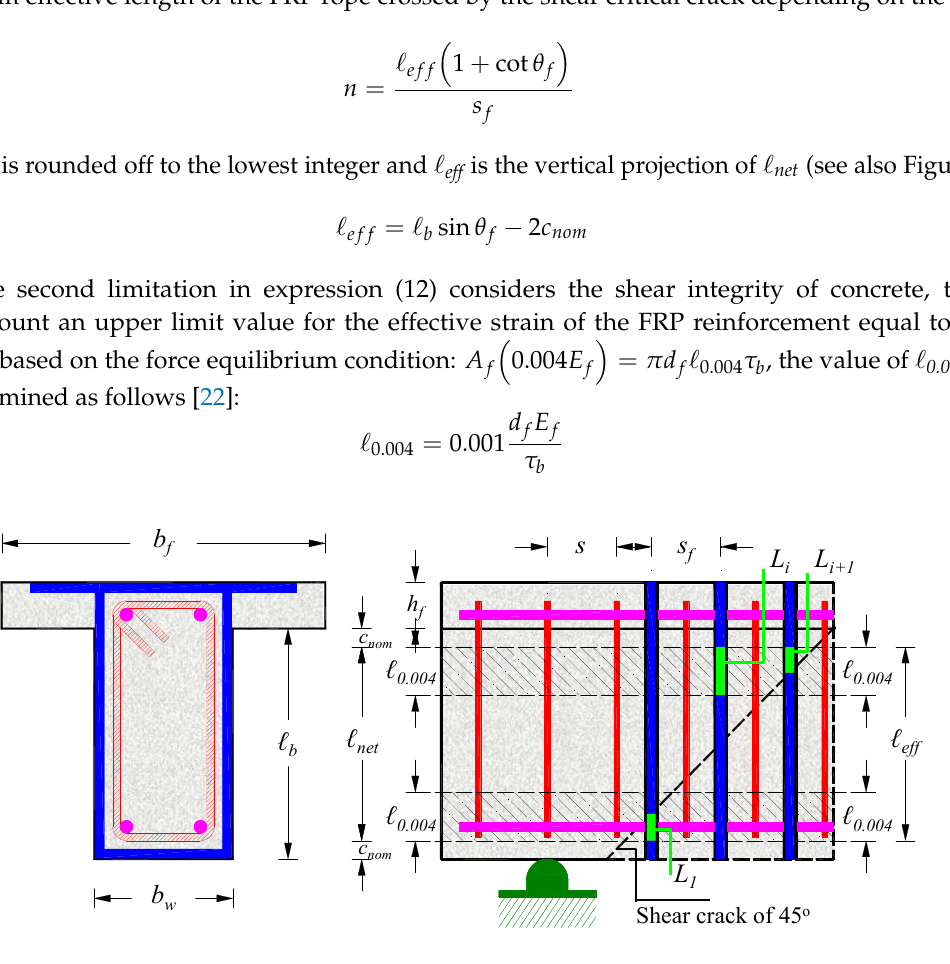
Figure 11. Graphical representation of the variables used in the formulation.